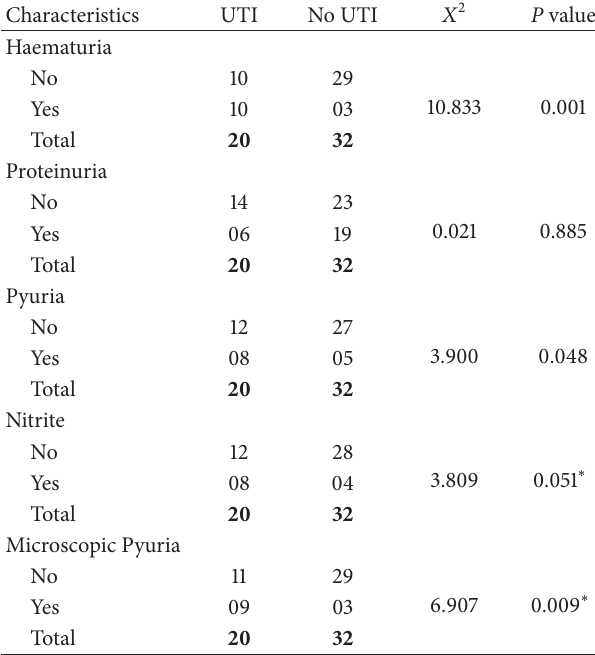
Table 5: Urinalyses findings among subjects with cerebral palsy and the relationship with